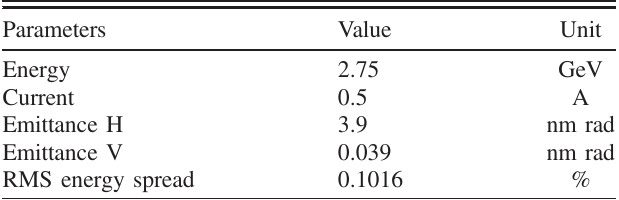
TABLE II. Characteristics of the electron beam in SOLEIL long section beam